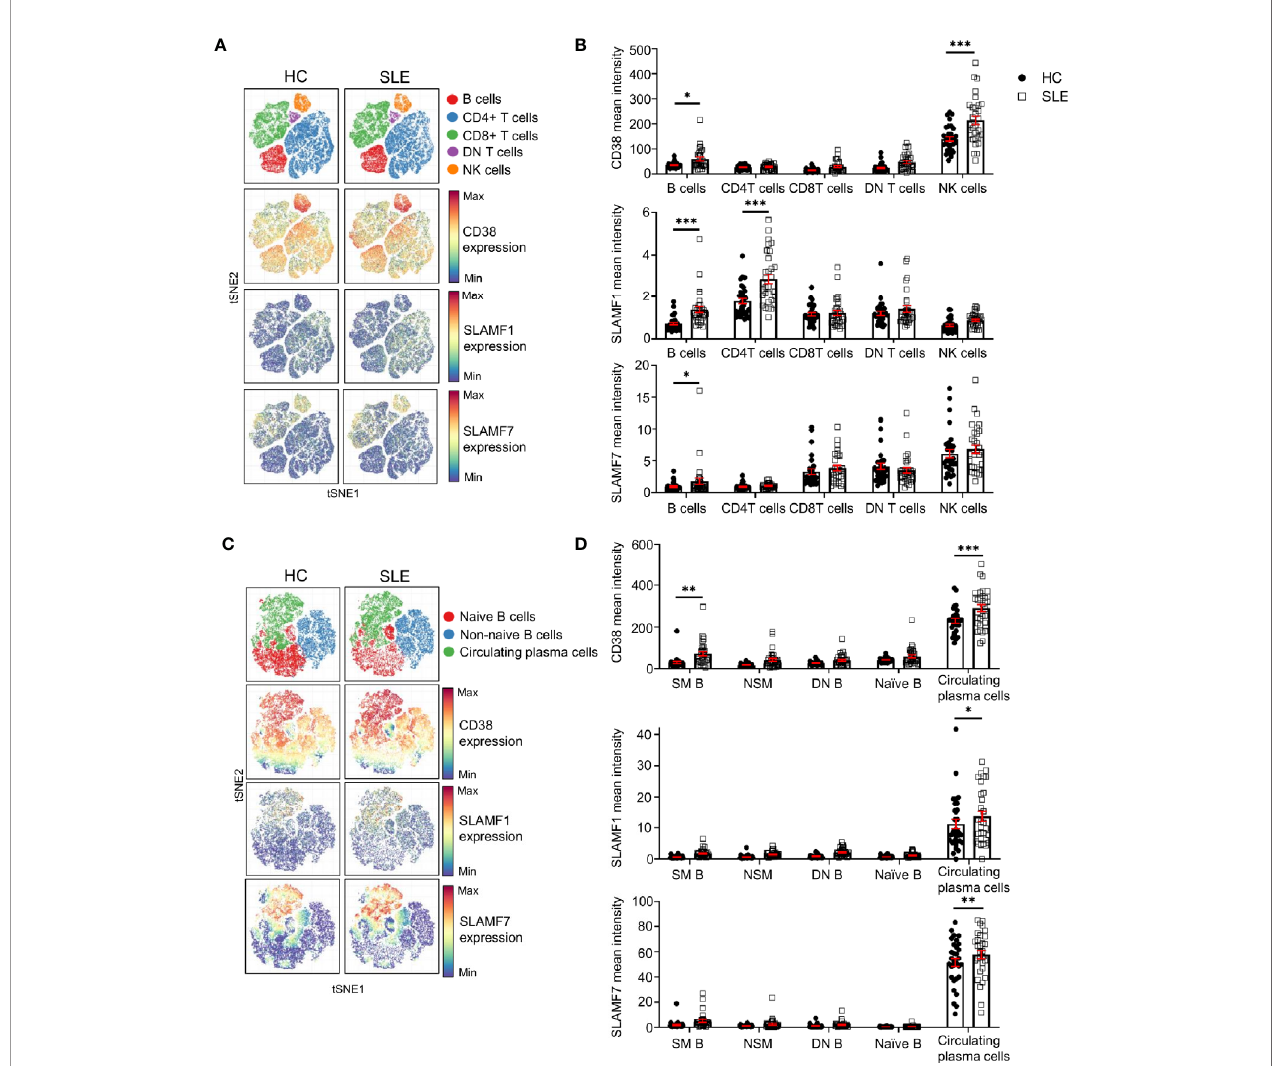
FIGURE 5 | Expression of CD38, SLAMF1 and SLAMF7 characterizes SLE circulating plasma cells. ( A ) t-SNE presentation of the expression level of CD38, SLAMF1 and SLAMF7 in main lymphocyte populations for HC and SLE patients (down-sample HC=100 ’ 000 cells and SLE=100 ’ 000 cells). (B) Comparison of mean expression level of CD38, SLAMF1 and SLAMF7 between HC and SLE patients in main lymphocyte populations (HC and SLE=31; two-way ANOVA with Sidak ’ s multiple comparison test). (C) t-SNE presentation of the expression level of CD38, SLAMF1 and SLAMF7 in B cell subpopulations for HC and SLE patients (down- sample N=10 ’ 000 cells per subpopulation HC and SLE=26). (D) Comparison of the mean expression level of CD38, SLAMF1 and SLAMF7 between HC and SLE patients in B cell sub-populations (HC=31, SLE =31; two-way ANOVA with Sidak ’ s multiple comparison test, SM, switch memory; NSM, non switch memory; DN, double negative). Data represent mean ± SEM (*P < 0.05, **P < 0.01, ***P < 0.001). HC, healthy